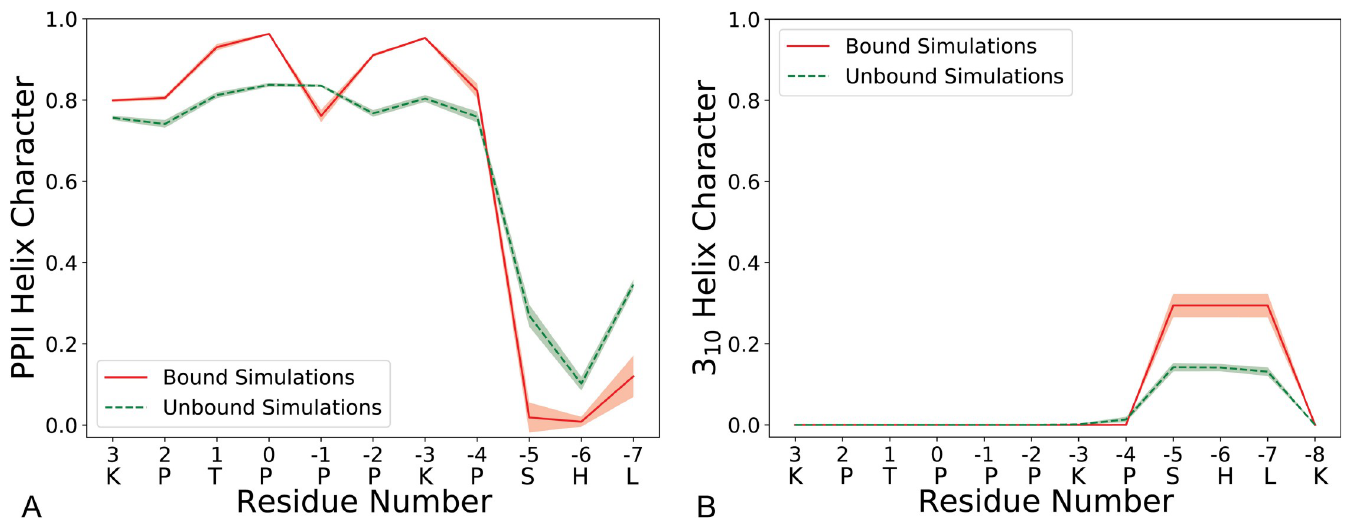
Fig 4. Quantifying bound and unbound secondary structure. Fraction of time each ArkA residue spends in PPII Helix (A) or 3 10 Helix (B) during the bound and unbound simulations. The one letter codes for ArkA residues are included on the x-axis. The shaded region represents the standard deviation between independent